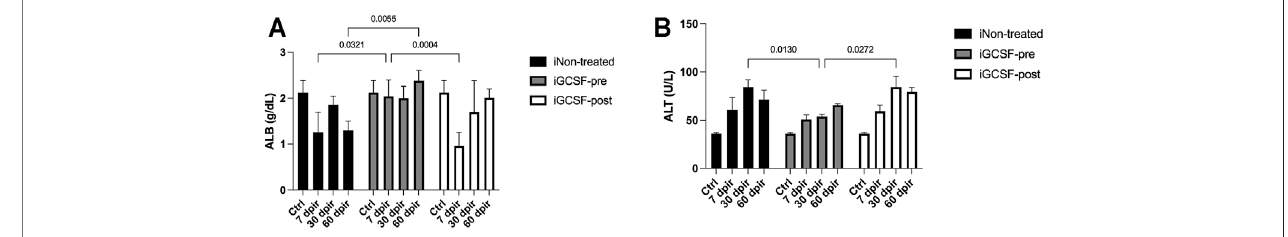
FIGURE1| Blood markersofliverfunctionandinjurybeforeand afterG-CSFtreatment.Serum albumin (ALB)levelsmeasuredonexperimental days 7,30,and60 in iNon-treated Group, iGCSF-pre and, iGCSF-post group (A) . Serum alanine aminotransferase (ALT) levels measured on experimental days 7, 30 and, 60 in iNon- treated Group, iGCSF-pre and, iGCSF-post group (B) . Multiple comparisons using two-way analysis of variance (ANOVA) followed by Tukey ’ s test were used. Data are represented as means ± SEM, p < 0.05 was considered signi fi cant, where * p < 0.05; ** p < 0.01 and *** p < 0.001) ( n (cid:1) 10 per Group).